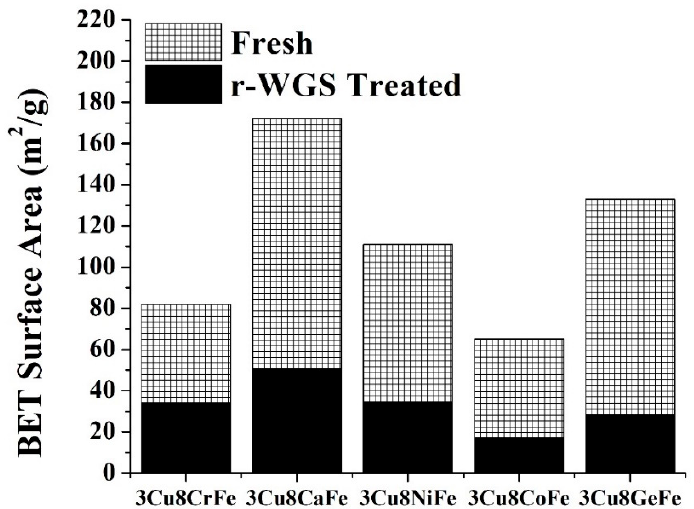
Figure 1. BET surface area of the freshly calcined catalysts and catalysts treated under r-WGS conditions (500 °C, 2 h).